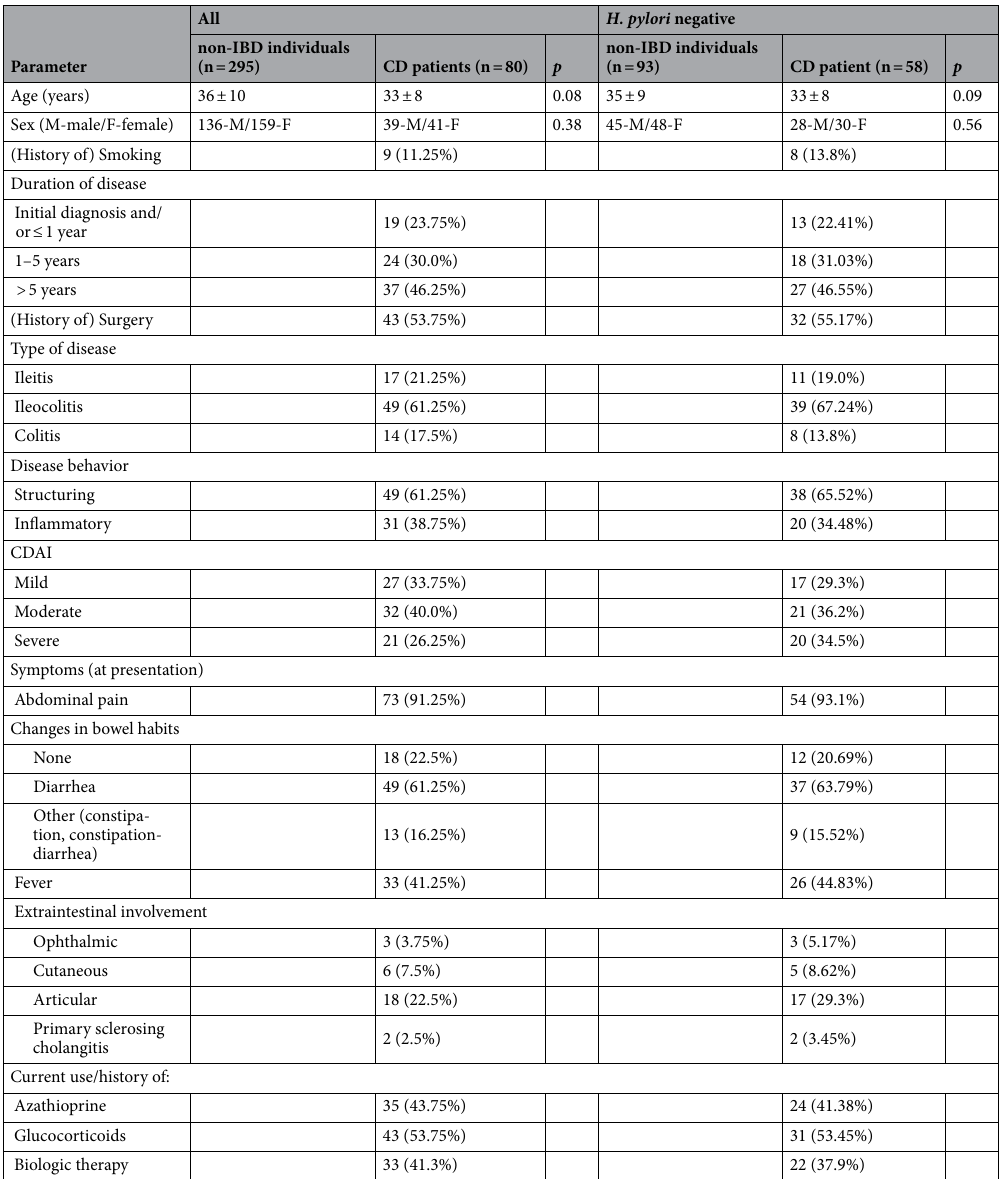
Table 2. General characteristics of all participants recruited to the study (data presented as means ± SD). CD Crohn’s disease, CDAI Crohn’s disease activity